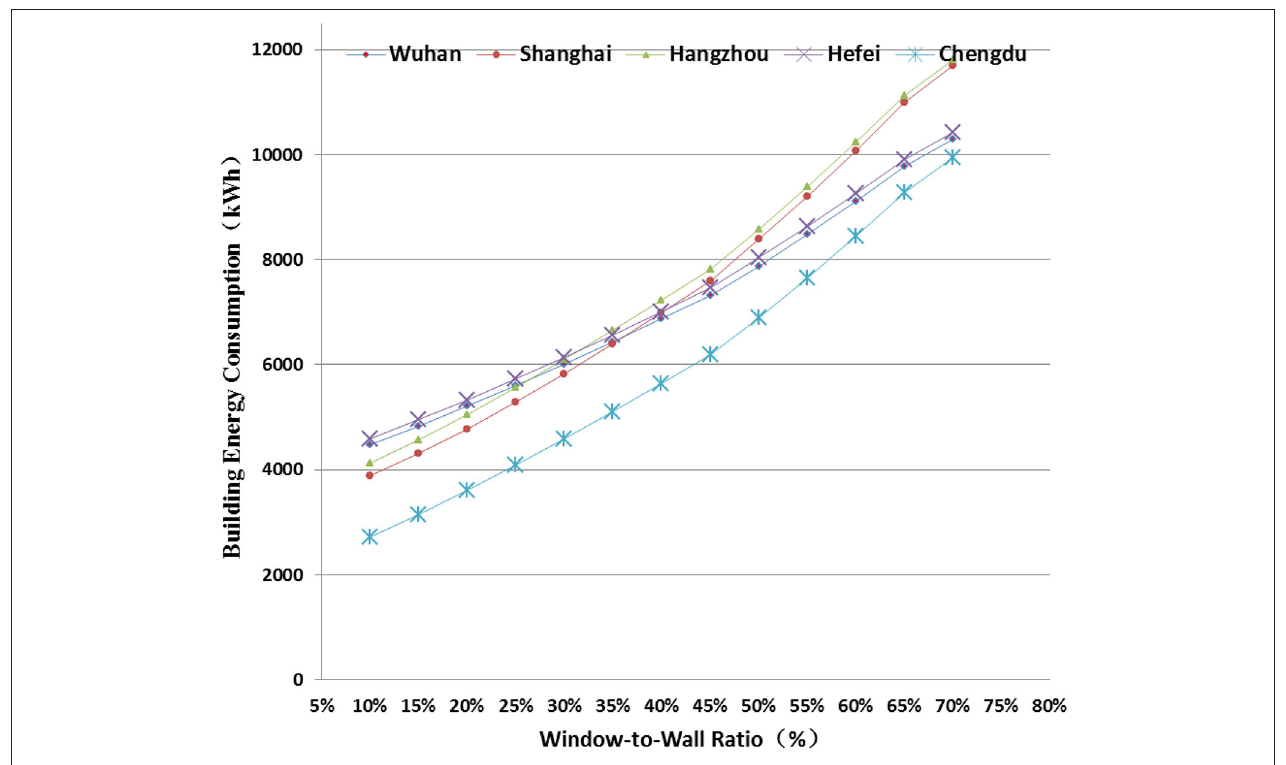
FIGURE 7 | Sensitivity analysis of the window-to-wall ratio on the annual energy consumption.